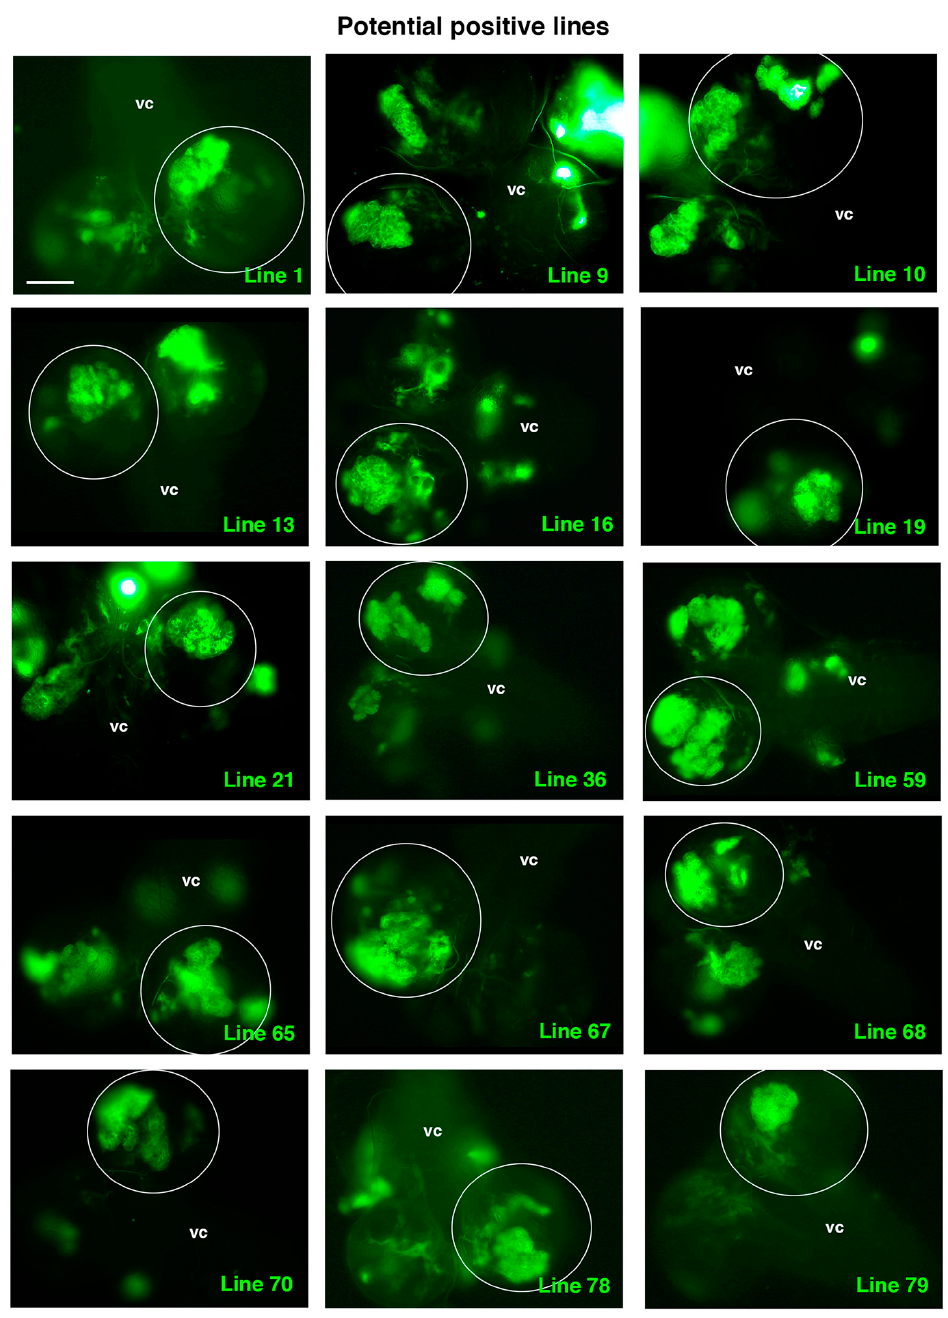
Figure 5. Potential positive lines selected. All panels show a dorsal view of a larval CNS that includes the ventral cord (vc) and the two-central brain (cb) hemispheres, one of which is encircled. All the selected experimental UAS-RNAi lines shown present clones with TLO and were considered potential positive lines following the established criteria (see text and Table 1). Scale bar: 100 µ m for all